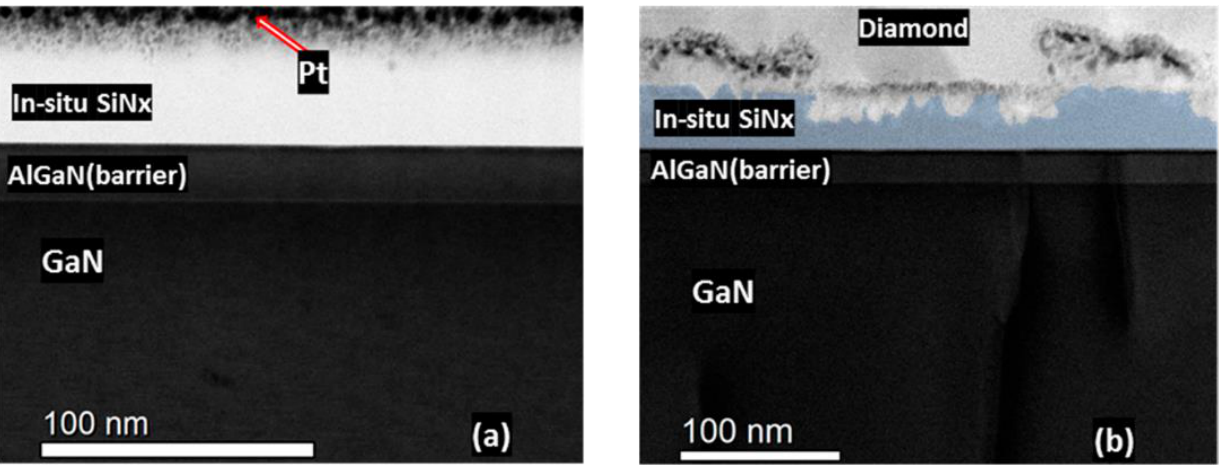
Figure 17. Bright-field STEM images showing the Al(Ga)N/SiN layer interfacial region ( a ) before and ( b ) after diamond growth (reprinted with permission from A. Siddique et al., “Structure and Interface Analysis of Diamond on an AlGaN/GaN HEMT Utilizing an in Situ SiNx Interlayer Grown by MOCVD,” ACS Appl. Electron. Mater., vol. 1, pp. 1387–1399, 2019 [91]. Copyright 2019 American Chemical Society).